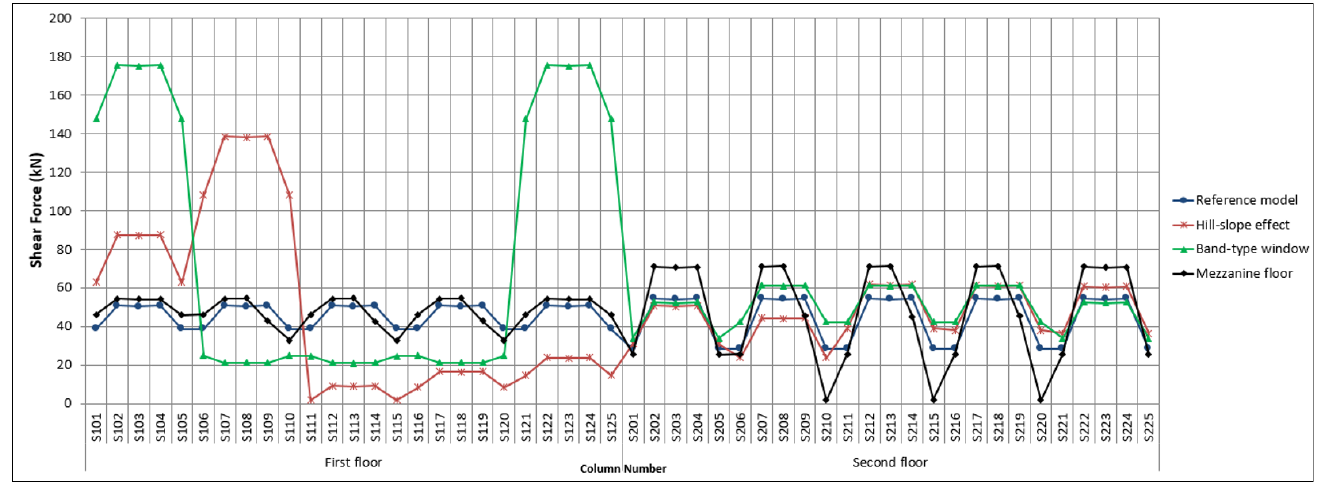
Figure 10. Column shear